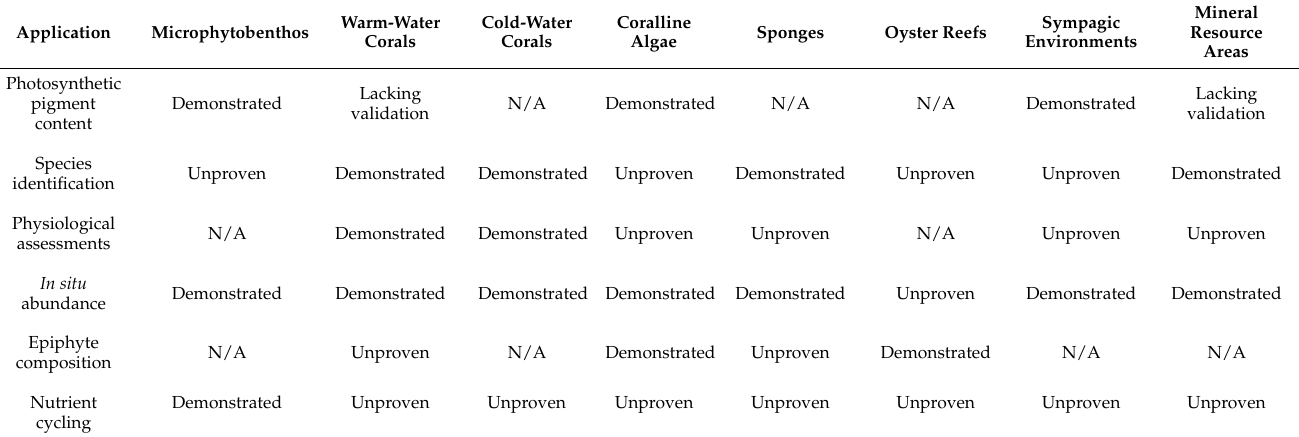
Table 3. Current application capabilities of proximal hyperspectral imaging for marine ecosystems and organisms (adapted from